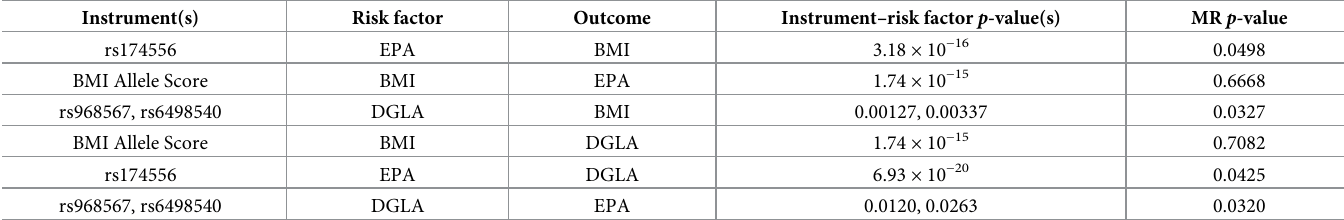
Table 1. Mendelian randomization results for TwinsUK data. The Instrument–risk factor p -value(s) are from the regression of the risk factor on the instrument(s), and the MR p -value is from the regression using the predicted value of the risk factor as an explanatory variable for the outcome variable, with the uncertainty in the predicted values from the first-stage regression taken into account through use of the R function ivreg().